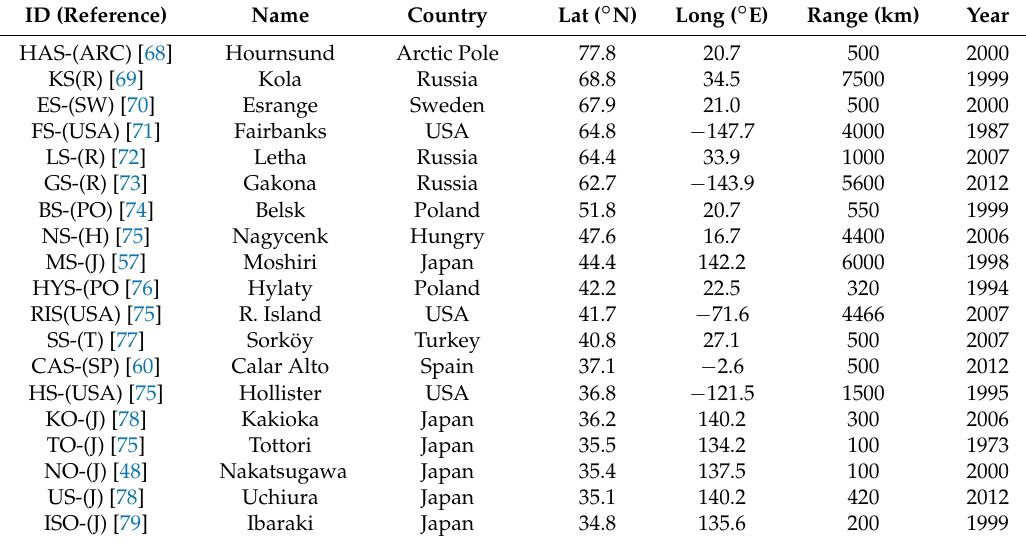
Table 1. Worldwide ELF (Extremely Low Frequency)